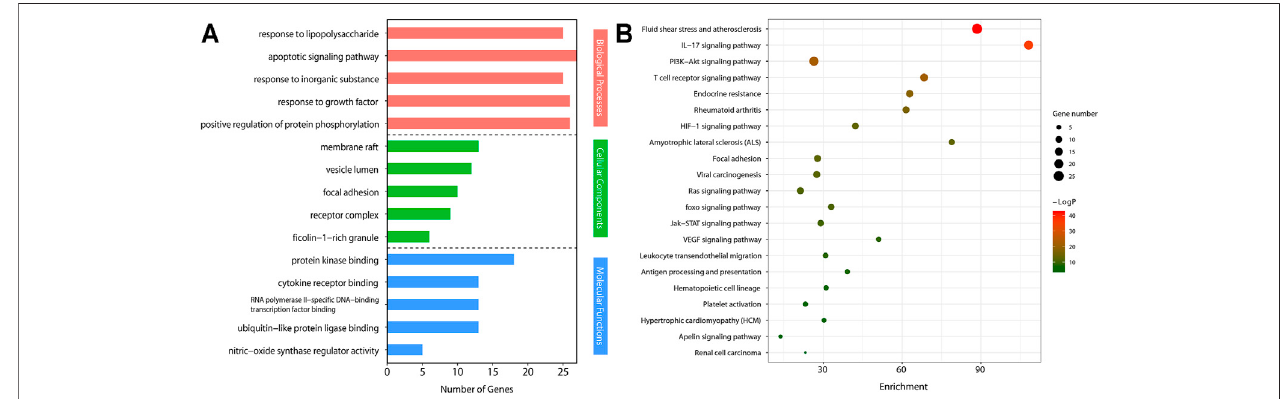
FIGURE5| GeneOntology(GO) analyses and Kyoto Encyclopedia ofGenesand Genomes(KEGG) pathways byMetascape. (A) GOenrichmentanalysisoftarget genes. The number of GO entries in the functional categories of biological process (BP), cell composition (CC), and molecular function (MF) ( p < 0.05). (B) KEGG pathways of target genes ( p < 0.05).